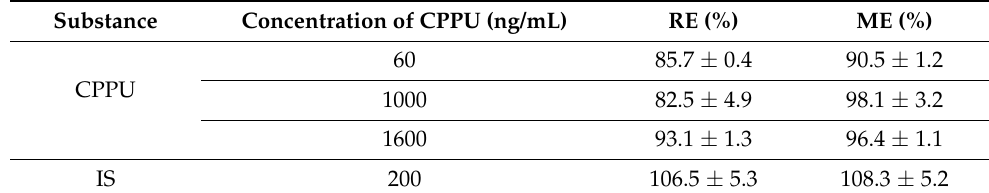
Table 2. Matrix effect and recovery of CPPU and IS ( n = 6).